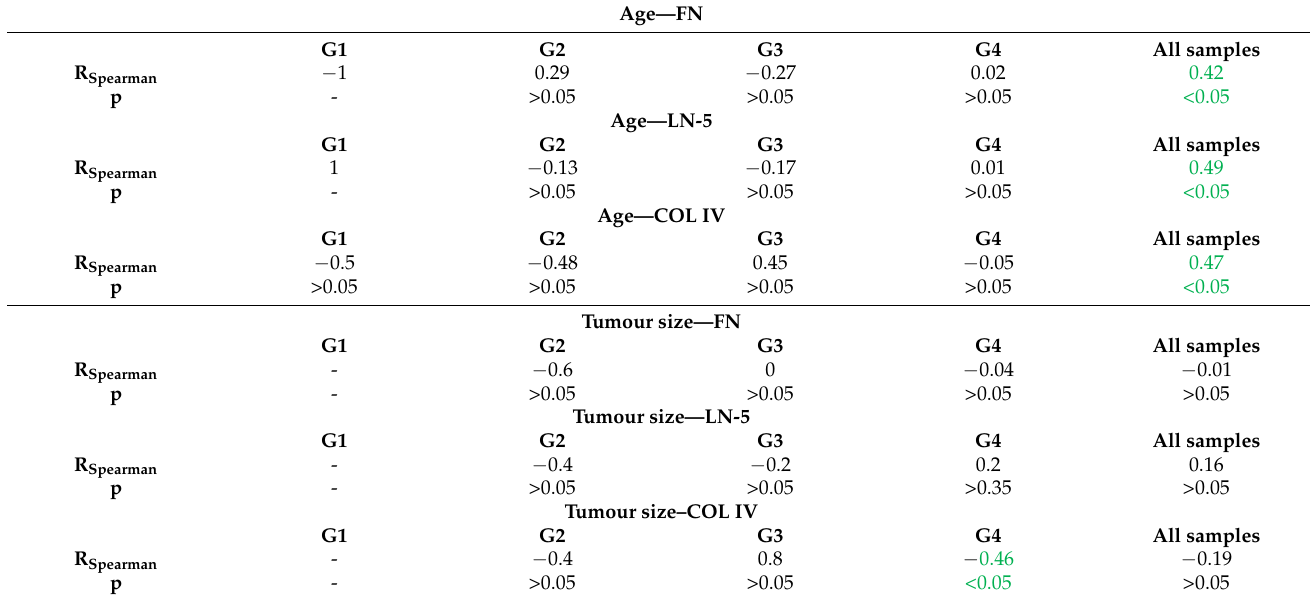
Table A2. Correlations: protein concentration—patient’s age and protein concentration—tumour size.